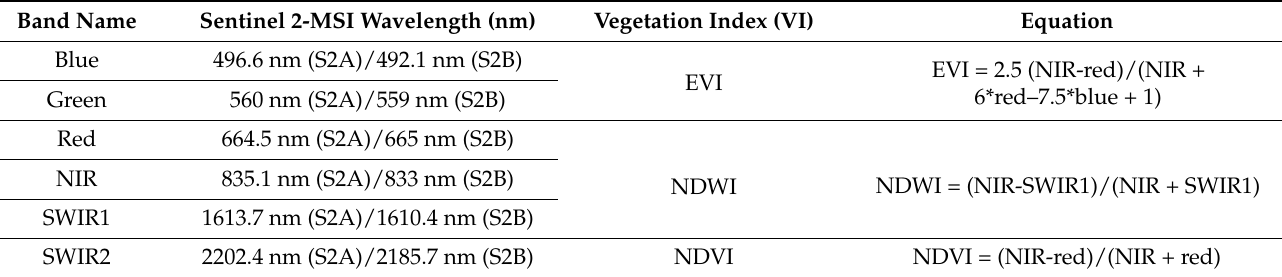
Table 6. Characteristics of Sentinel 2 MSI data used in this